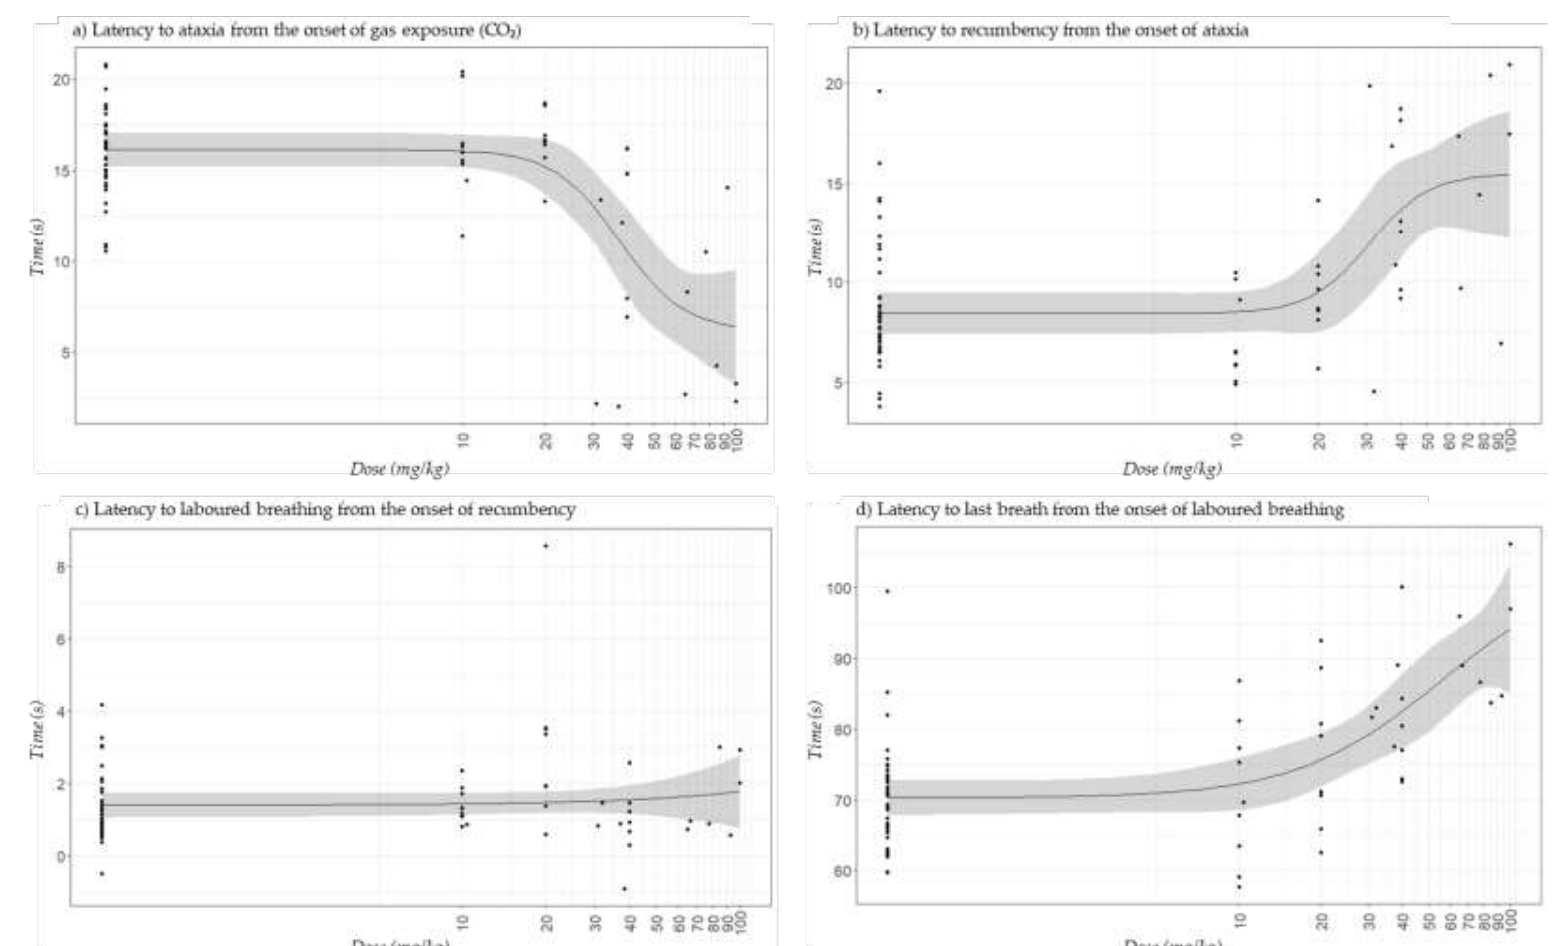
Figure 3. Predicted plots ( ± 95% confidence interval) for the different behaviours observed during euthanasia with CO 2 for the actual doses of the sedative tiletamine-zolazepam in C57BL/6 mice: ( a ) latency to ataxia from the onset of gas exposure (CO 2 ); ( b ) latency to recumbency from the onset of ataxia; ( c ) latency to laboured breathing from the onset of recumbency; ( d ) latency to last breath from the onset of laboured breathing. Mice were observed until last breath (1.67 ± 0.31 min; mean ± SD). Each dot represents an individual mouse.